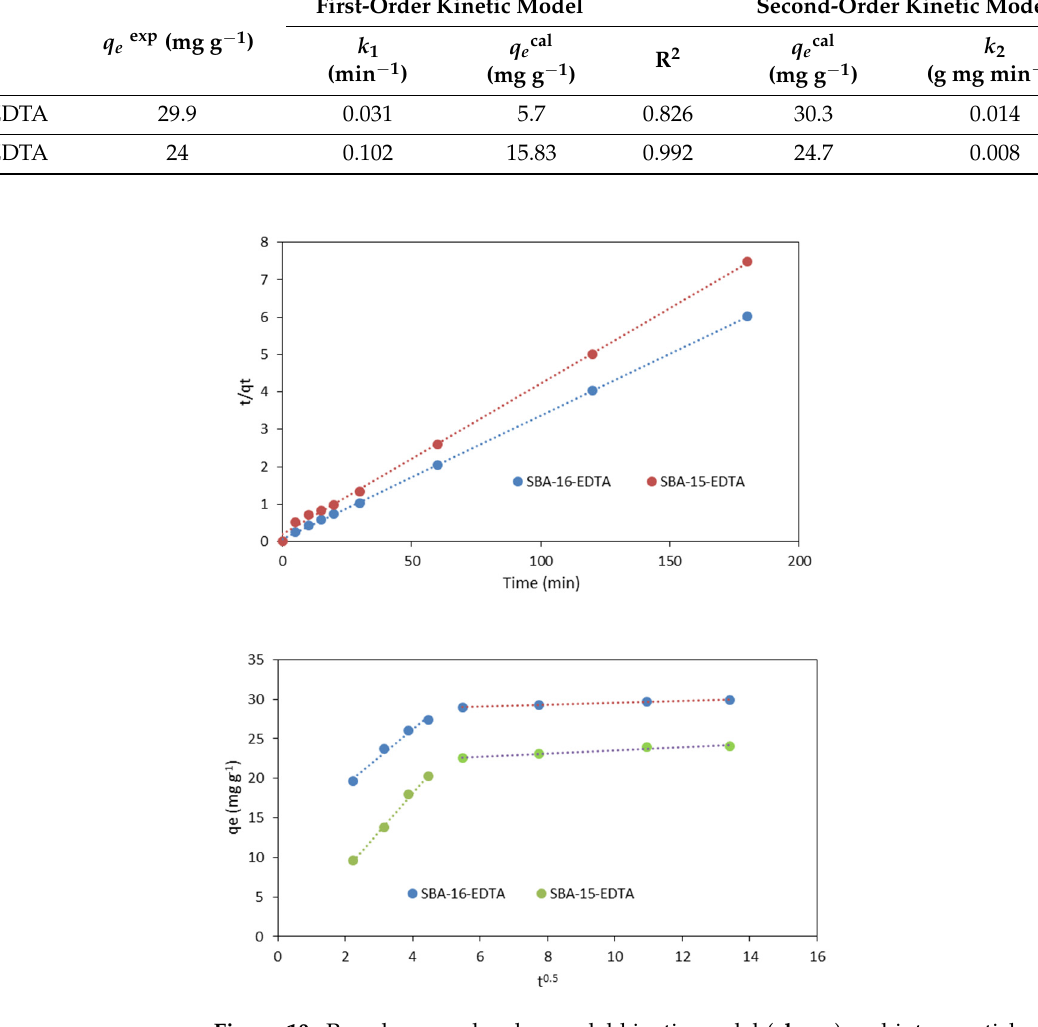
Figure 10. Pseudo-second-order model kinetic model ( above ) and intra-particle diffusion model Figure 10. Pseudo ‒ second ‒ order model kinetic model ( above ) and intra-particle diffusion model ( below ) for Zn 2+ adsorption (pH = 6 at ( below ) for Zn 2+ adsorption (pH = 6 at RT).